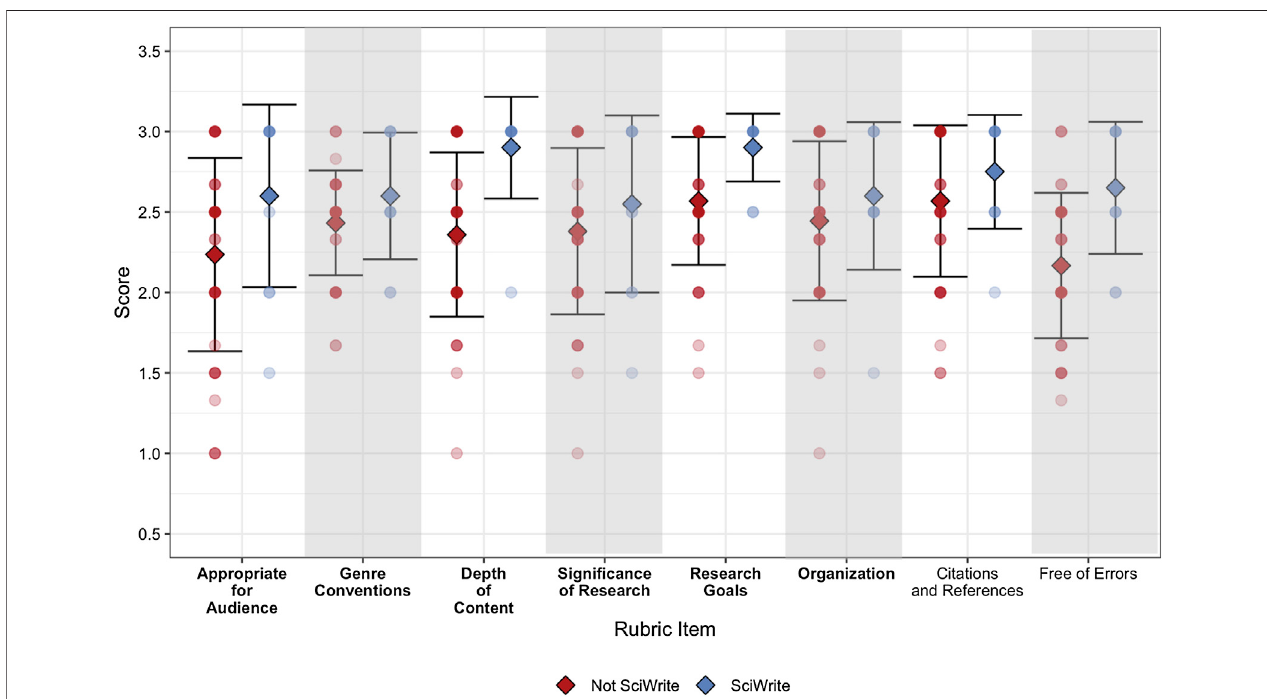
FIGURE 3 | Each of the eight rubric item scores (mean ± SD) for proposals written by SciWrite and non-SciWrite students. Mean scores are diamonds. Scores of individual students on each rubric item are the circular points with darker points for scores earned by at least fi ve students and lighter points for scores earned by fewer than four students. Rubric items in bold address higher-order concerns.